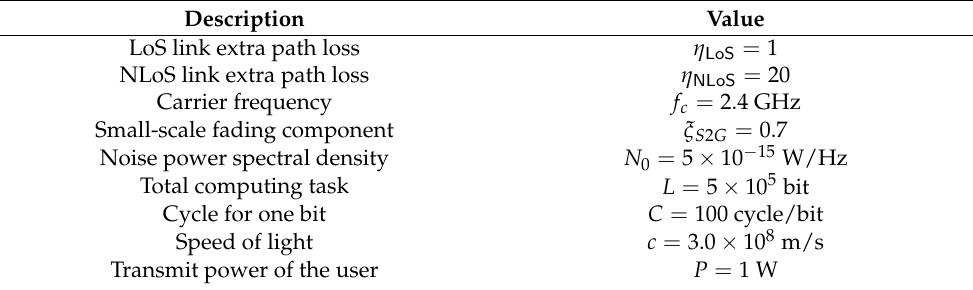
Table 2. Simulation